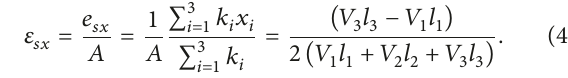
where 𝑙 𝑤 and ℎ are, respectively, the length and height of the shear wall, 𝜀 𝑦 is the yield strain of longitudinal reinforcements, and 𝐶 is a coefficient related to the shape of lateral force distribution and element section. For example, for a cantilever shear wall with lateral load acting on the top of the wall (as in a single-story building), the value of 𝐶 is equal to